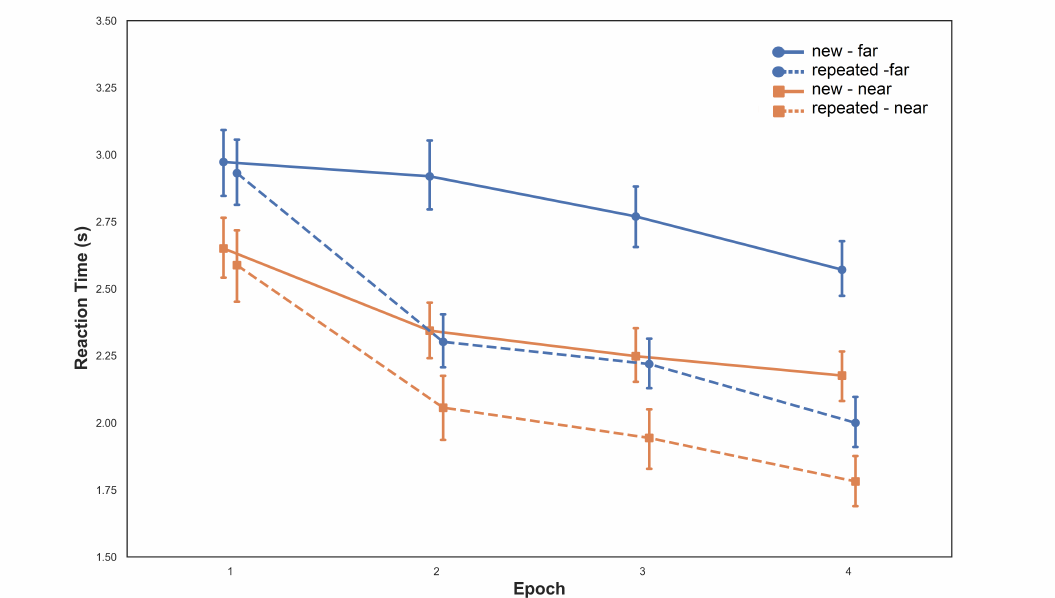
Figure 3. Mean reaction times as a function of epoch and associated standard errors for both repeated and new configurations. Solid lines depict new configurations, dashed lines depict repeated configurations. Blue lines indicate trials with the target outside of the initial FOV (far), orange lines indicate trials with the target inside the initial FOV